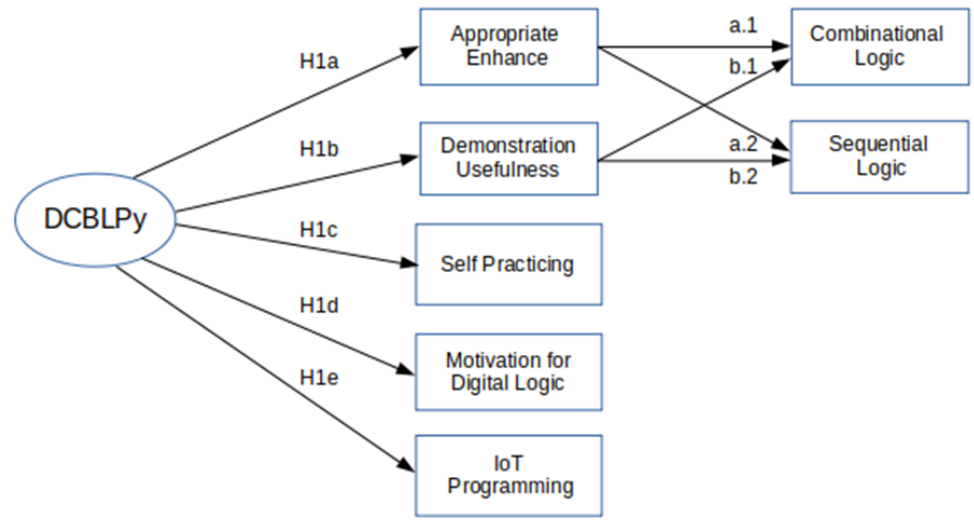
Figure 3. Relation between areas of interest and hypotheses.